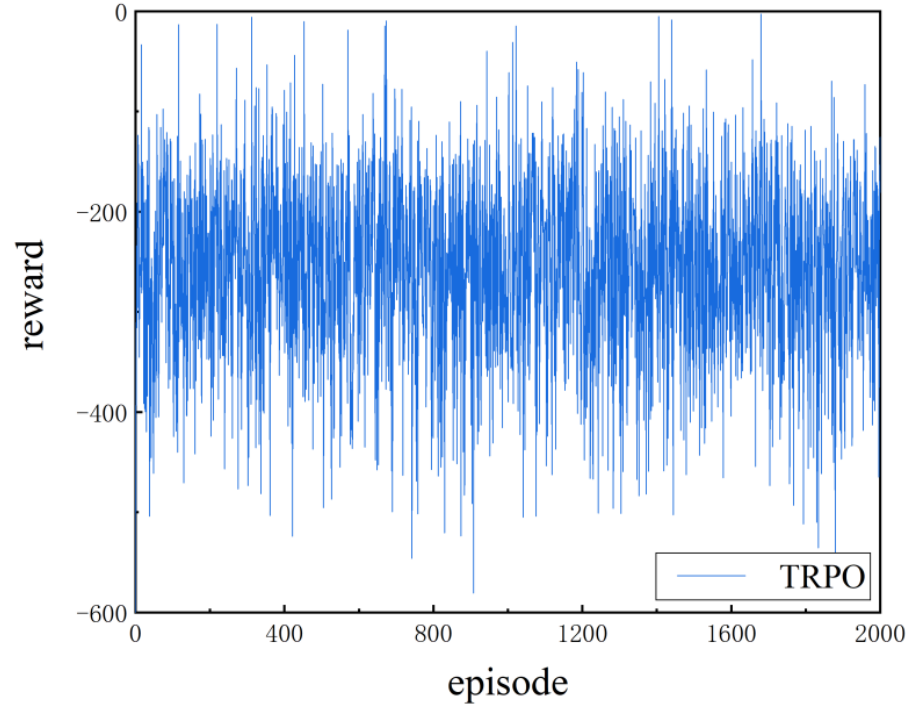
Figure 10. The relationship between the reward value of the TRPO algorithm and the number of rounds.